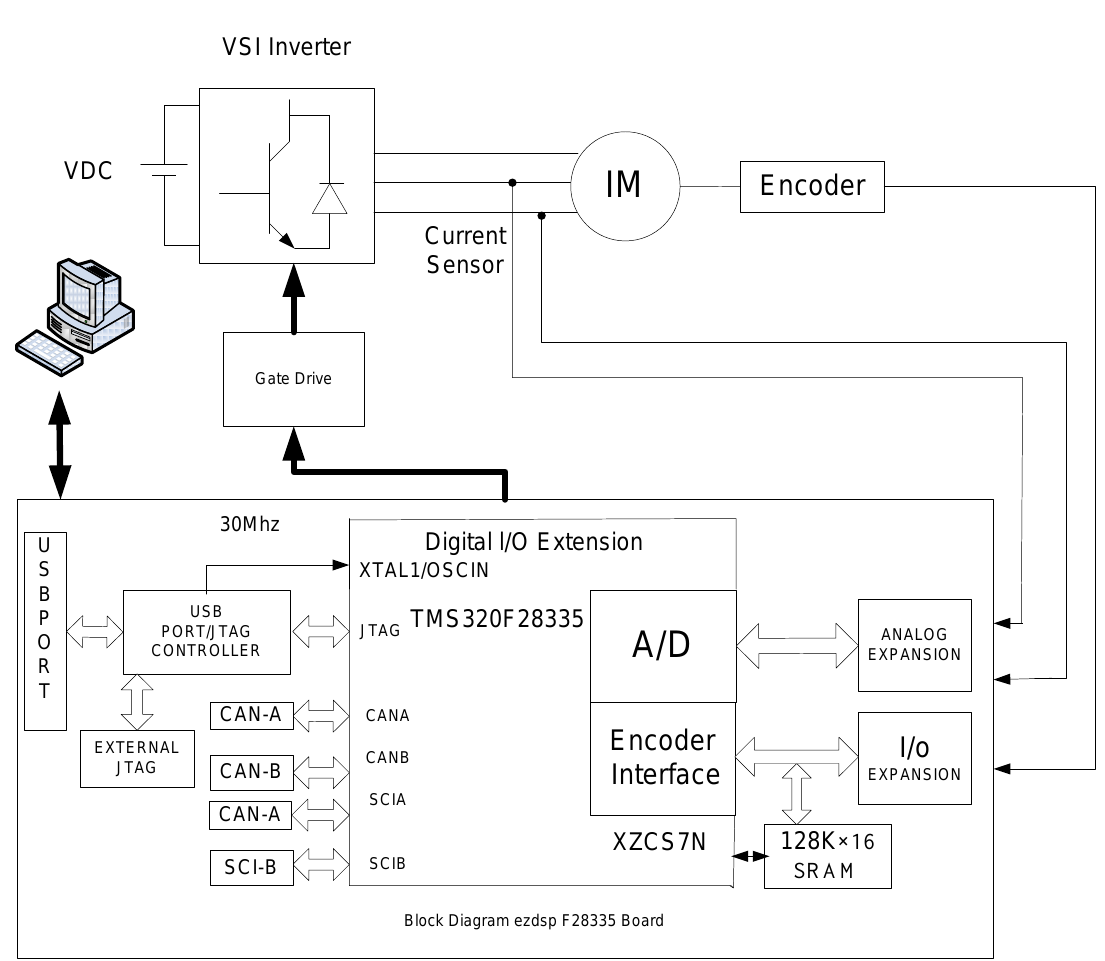
Figure 14. Block diagram of the hardware schematic for real-time implementation of VSI fed IM drive.